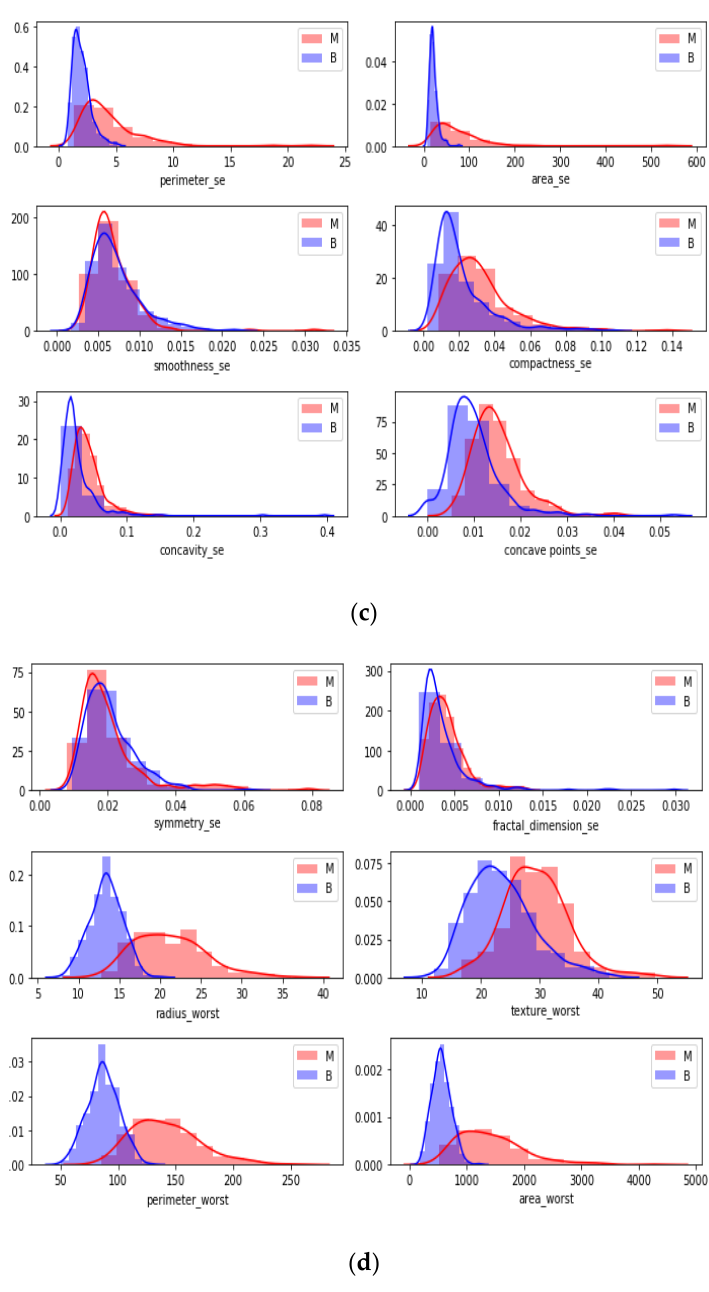
Figure 6. Pairwise plots of Breast Cancer Dataset attributes.